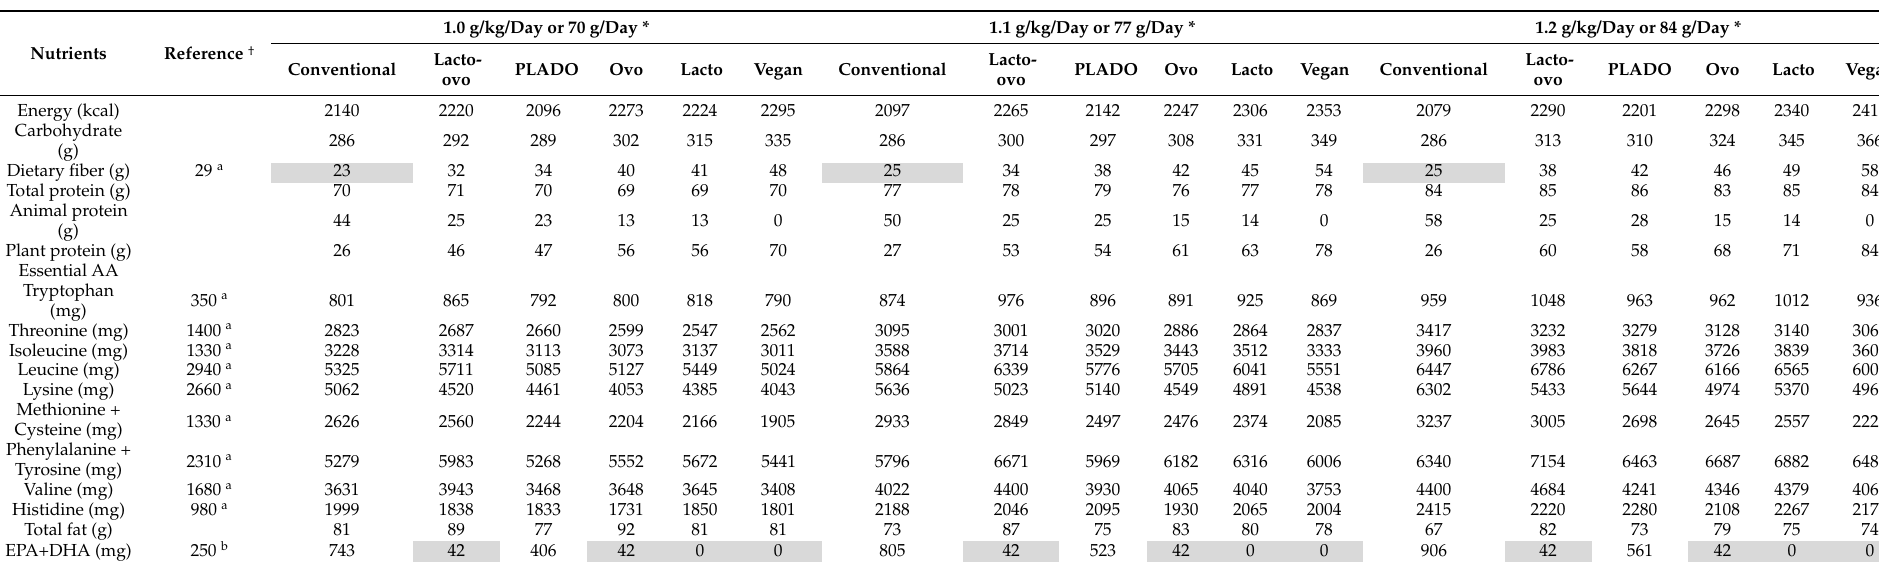
Table 3. Macronutrients, essential amino acids, and long-chain n -3 polyunsaturated fatty acids of conventional, plant-based, and vegetarian moderately high protein